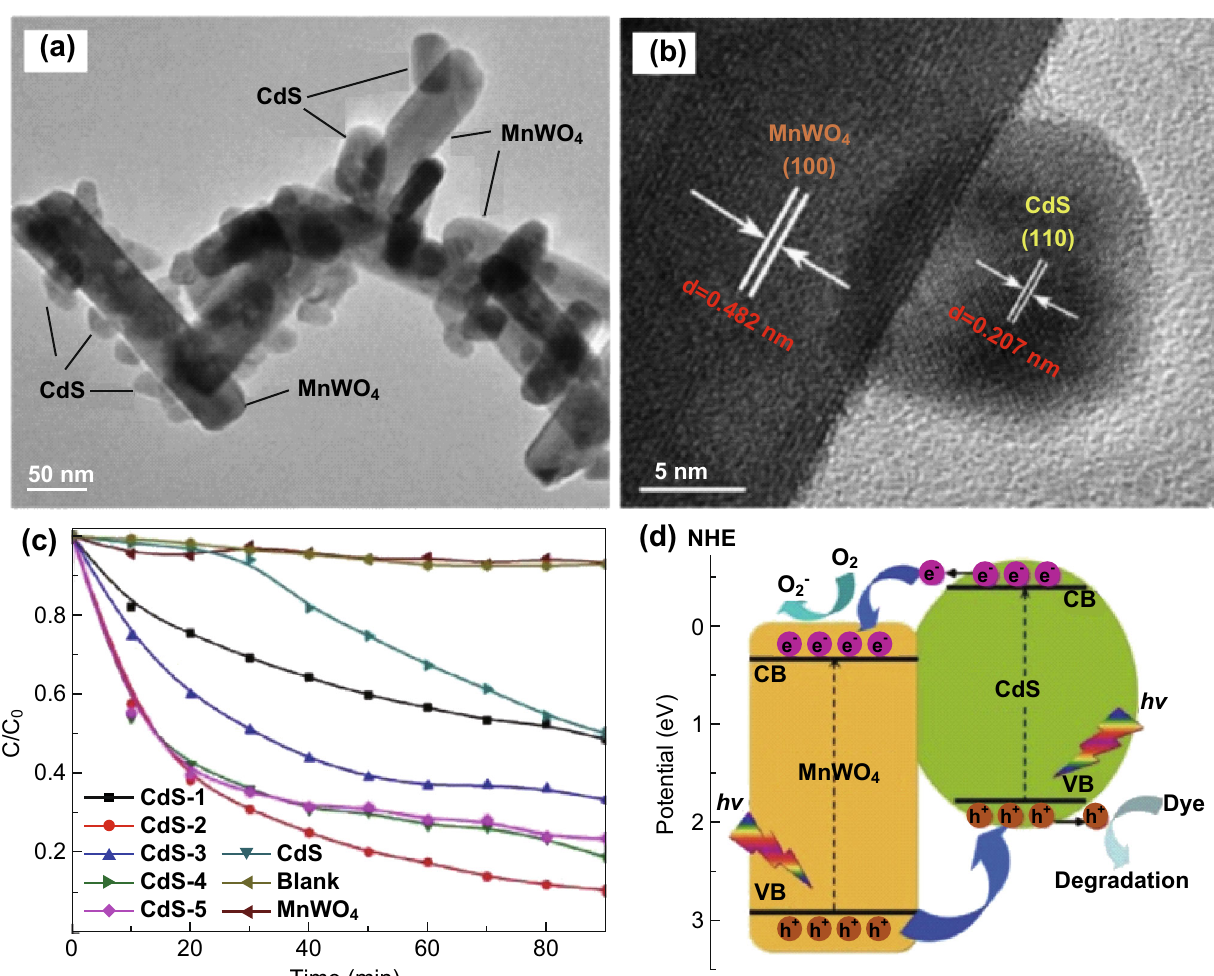
Fig. 14 a , b TEM and HRTEM images of a CdS/MnWO 4 heterojunction. c Photocatalytic degradation of MB over CdS/MnWO 4 with different CdS contents. d Schematic photocatalytic mechanism of CdS/MnWO 4 heterojunction. Reproduced with permission from Ref. [155].